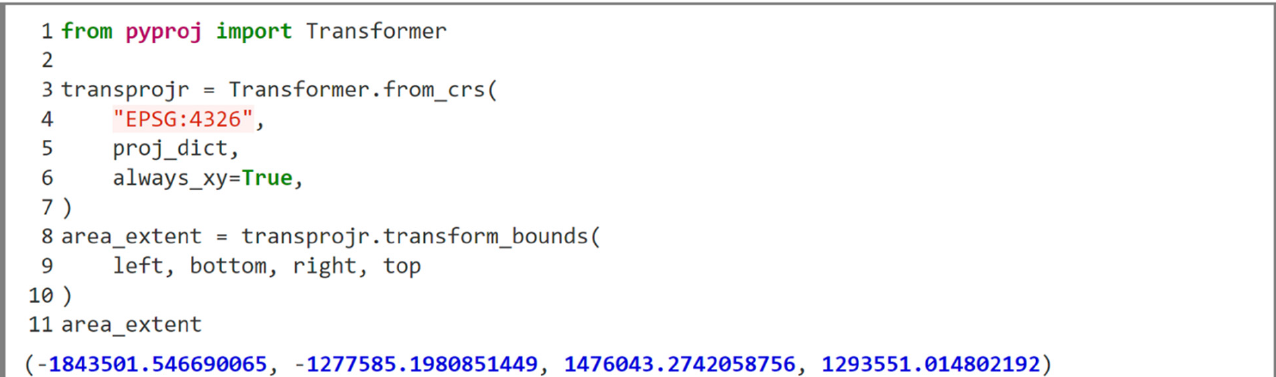
Figure A2. Python code snippet for projection initialization. The Lambert azimuthal equal-area pro- jection (LAEA) is initialized with the center located at the swath scan line center longitude/latitude median point. The initialized projection was then used to translate the swath bounds in degrees into the target projection distances in meters. WGS84 stands for World Geodetic System (WGS) 1984, consisting of a reference ellipsoid, a standard coordinate system, altitude data, and a geoid.